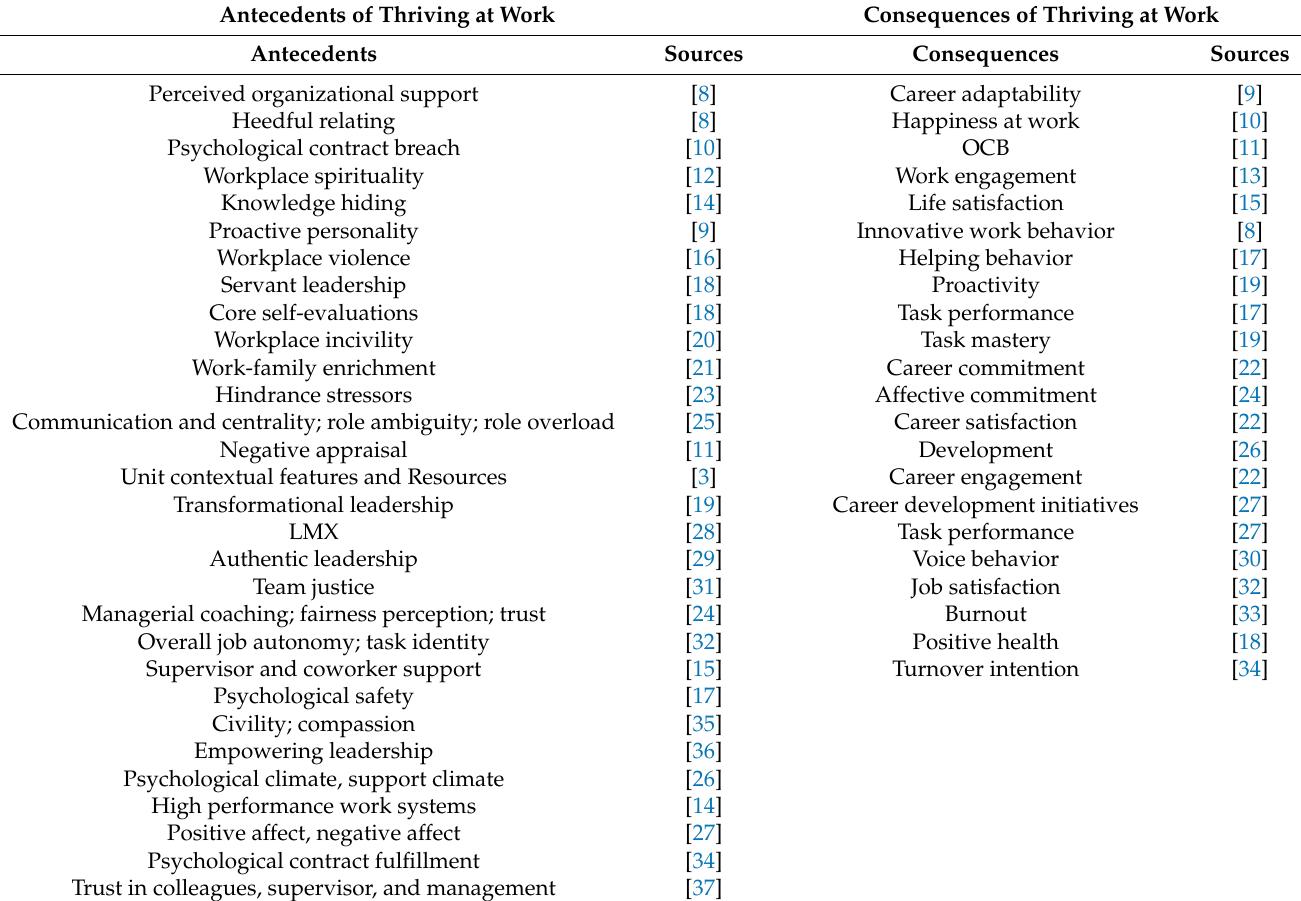
Table 1. Antecedents and consequences of thriving at